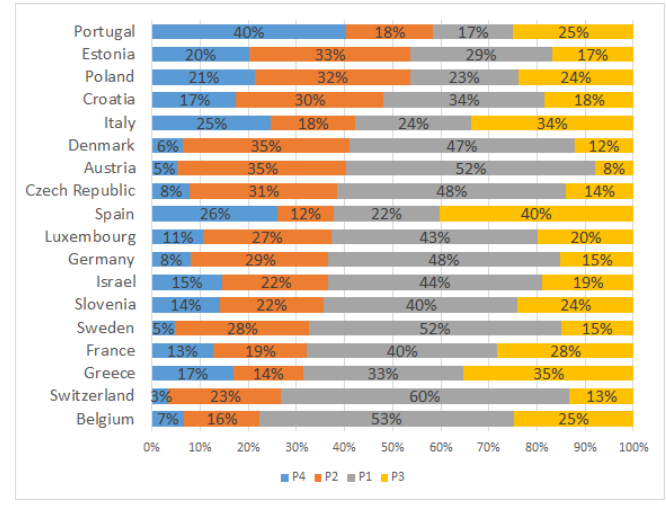
Figure 6. Distribution of P1–P4 profiles by